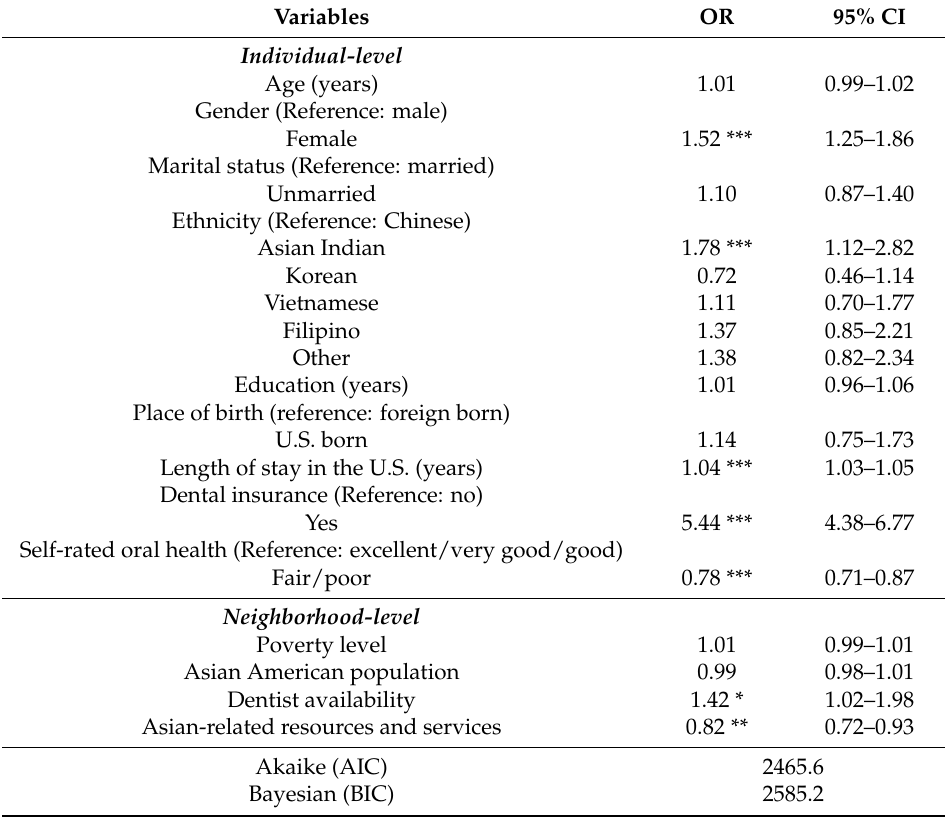
Table 3. Multilevel logistic regression model of the use of preventive dental care